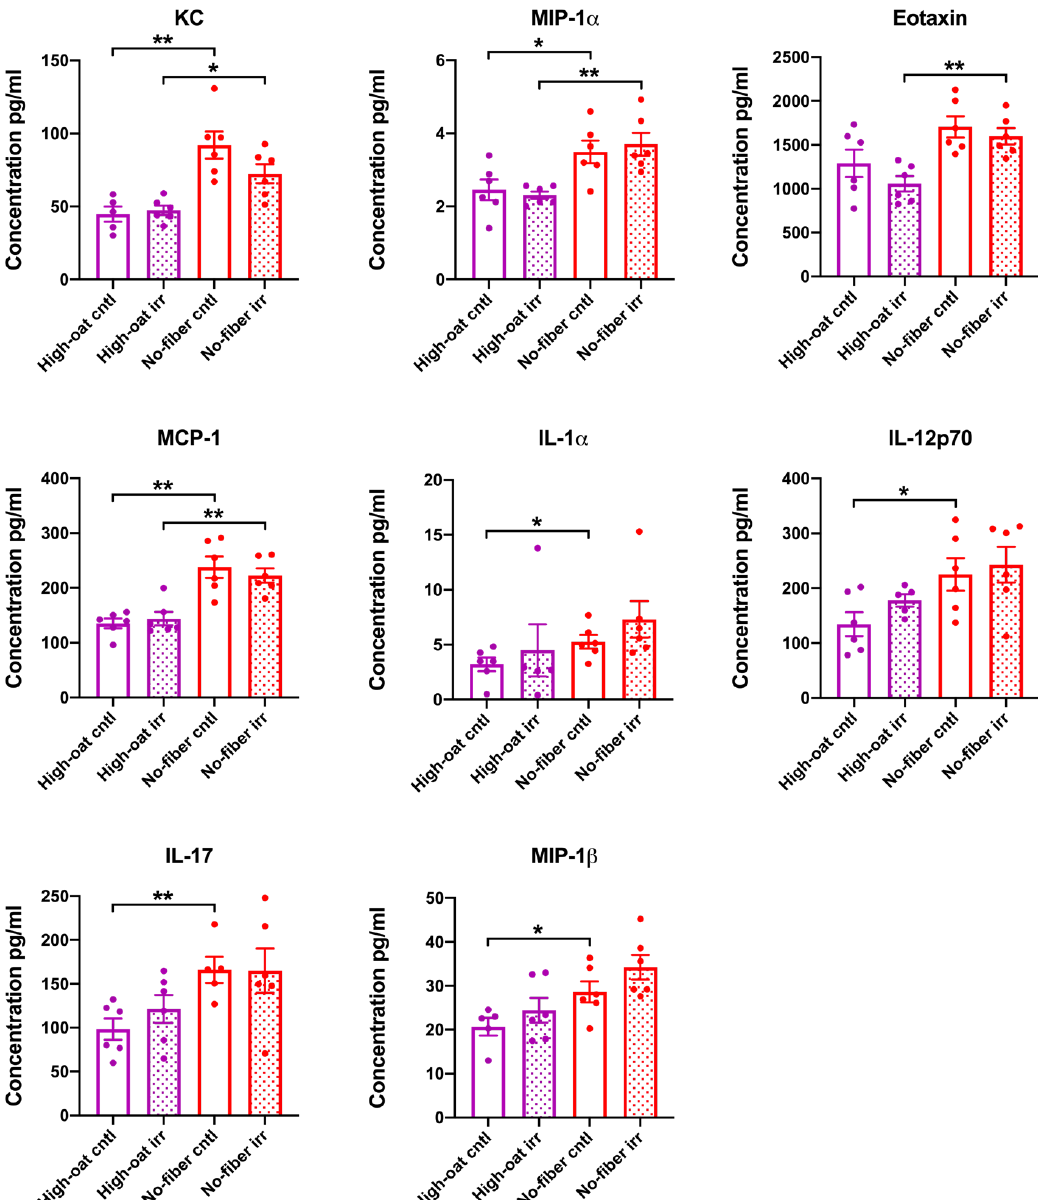
Figure 6. Serum cytokine and chemokine levels in mice at 18 weeks post-irradiation. A two-tailed Mann–Whitney test was used to compare the cytokine and chemokine levels in High-oat irr vs. High-oat cntl, No-fiber irr vs. No-fiber cntl, High-oat irr vs. No-fiber irr, and High-oat cntl vs. No-fiber cntl groups. Data shown are average concentrations and the error bars represent SEM. * p ≤ 0.05; and ** p ≤ 0.01.